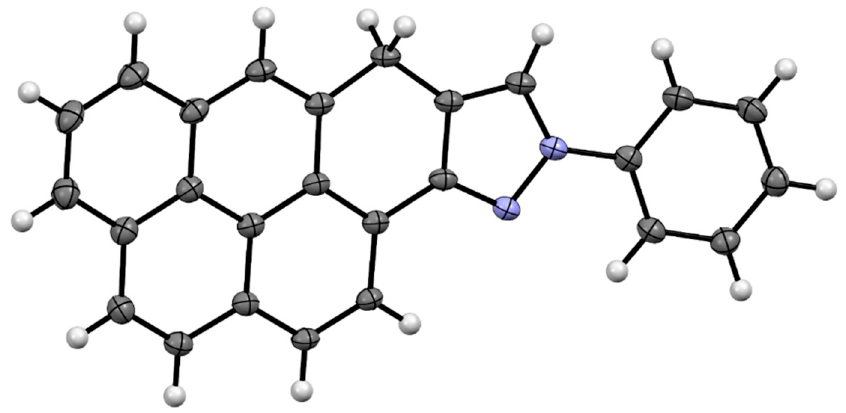
Figure 3. Molecular structure of compound 3 , determined by X-ray diffraction.